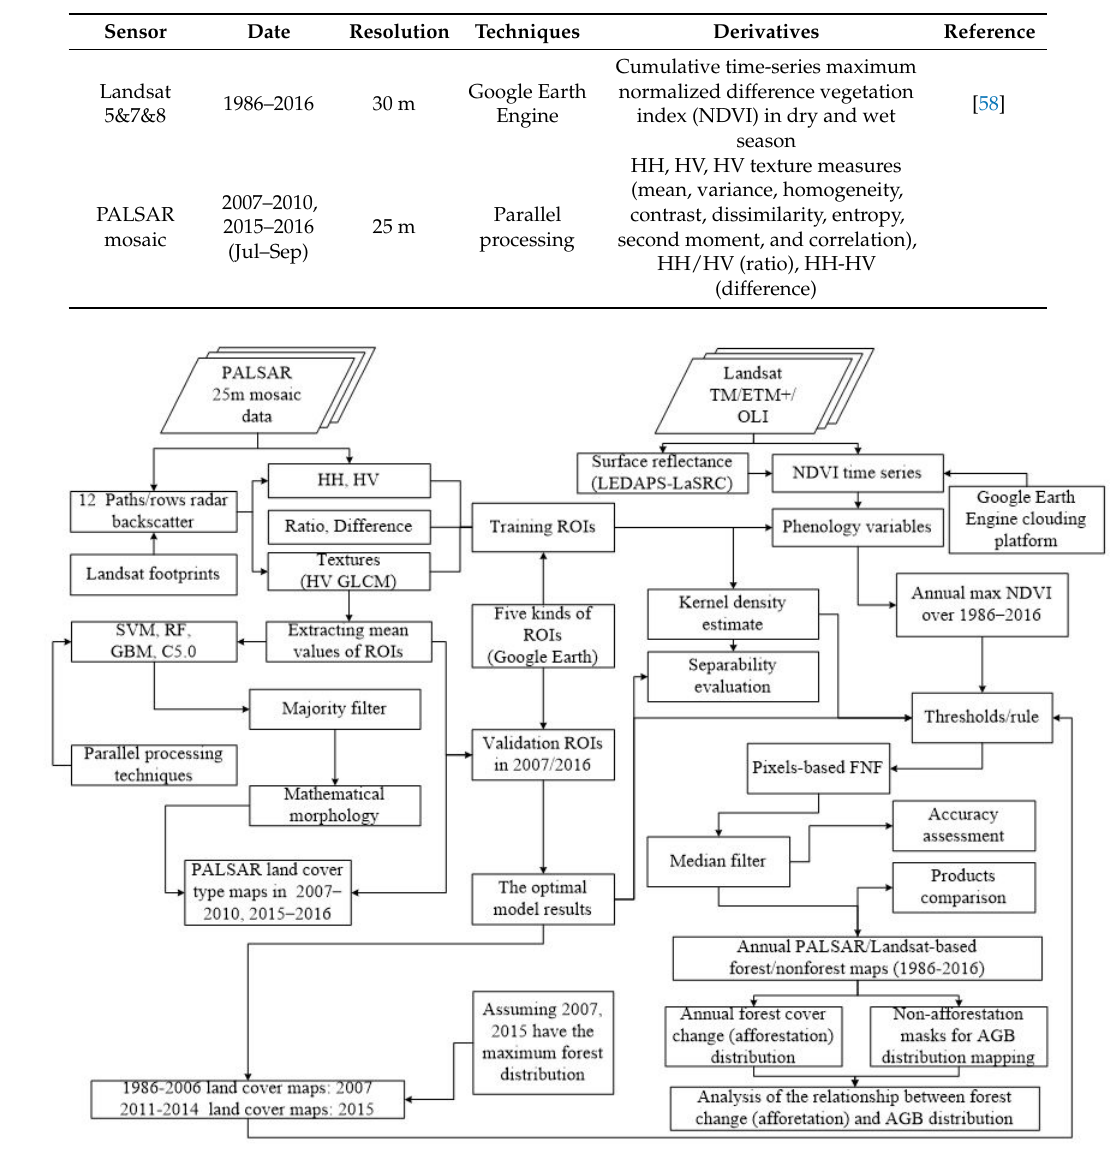
Table 1. Summary of satellite data used in this study.